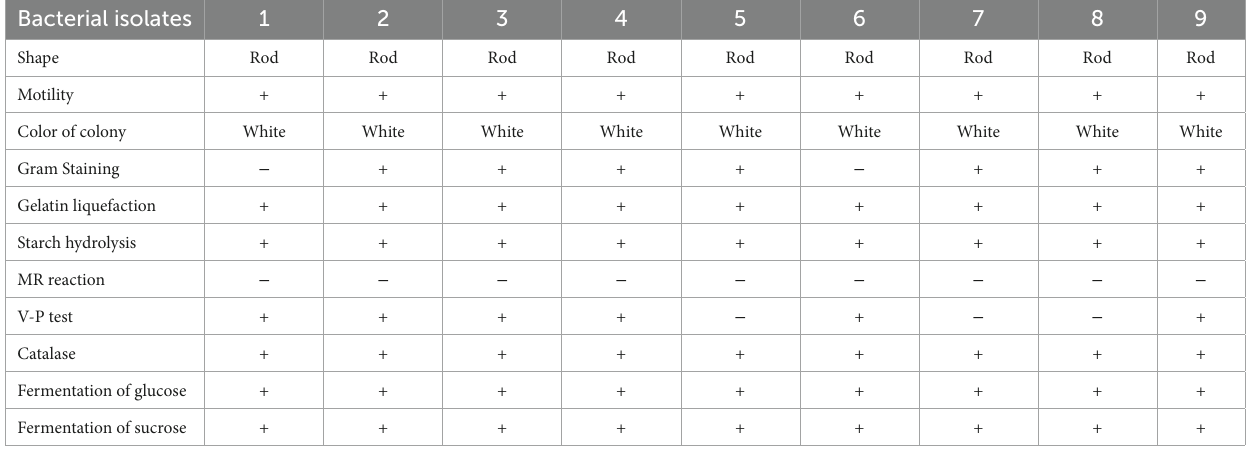
TABLE 1 Morphological, physiological and biochemical characters of nine antagonistic bacteria. Bacterial